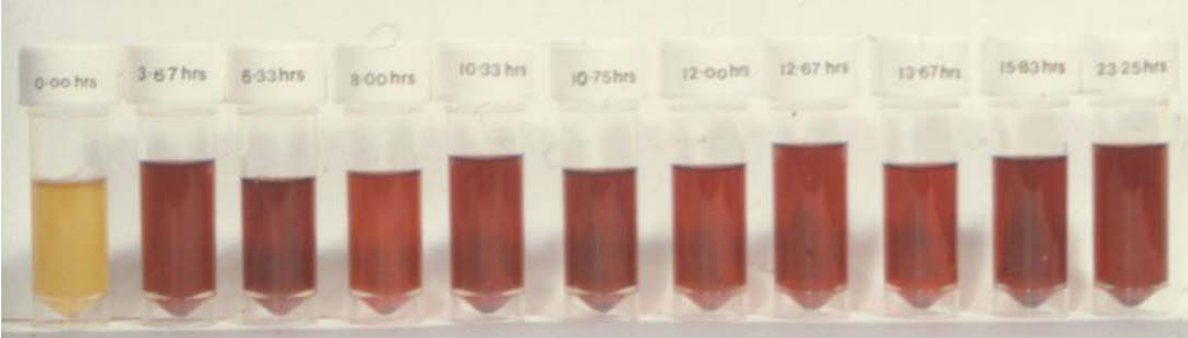
Figure 7. The sequential urinary iron excretion profile following intensive chelation therapy with deferiprone (L1) in a heavily iron-loaded thalassemia patient. Divided doses of L1 to a total of 250 mg/kg were administered in the thalassemia patient and sequential urine samples were collected over 24 h, totaling 325 mg of iron (see